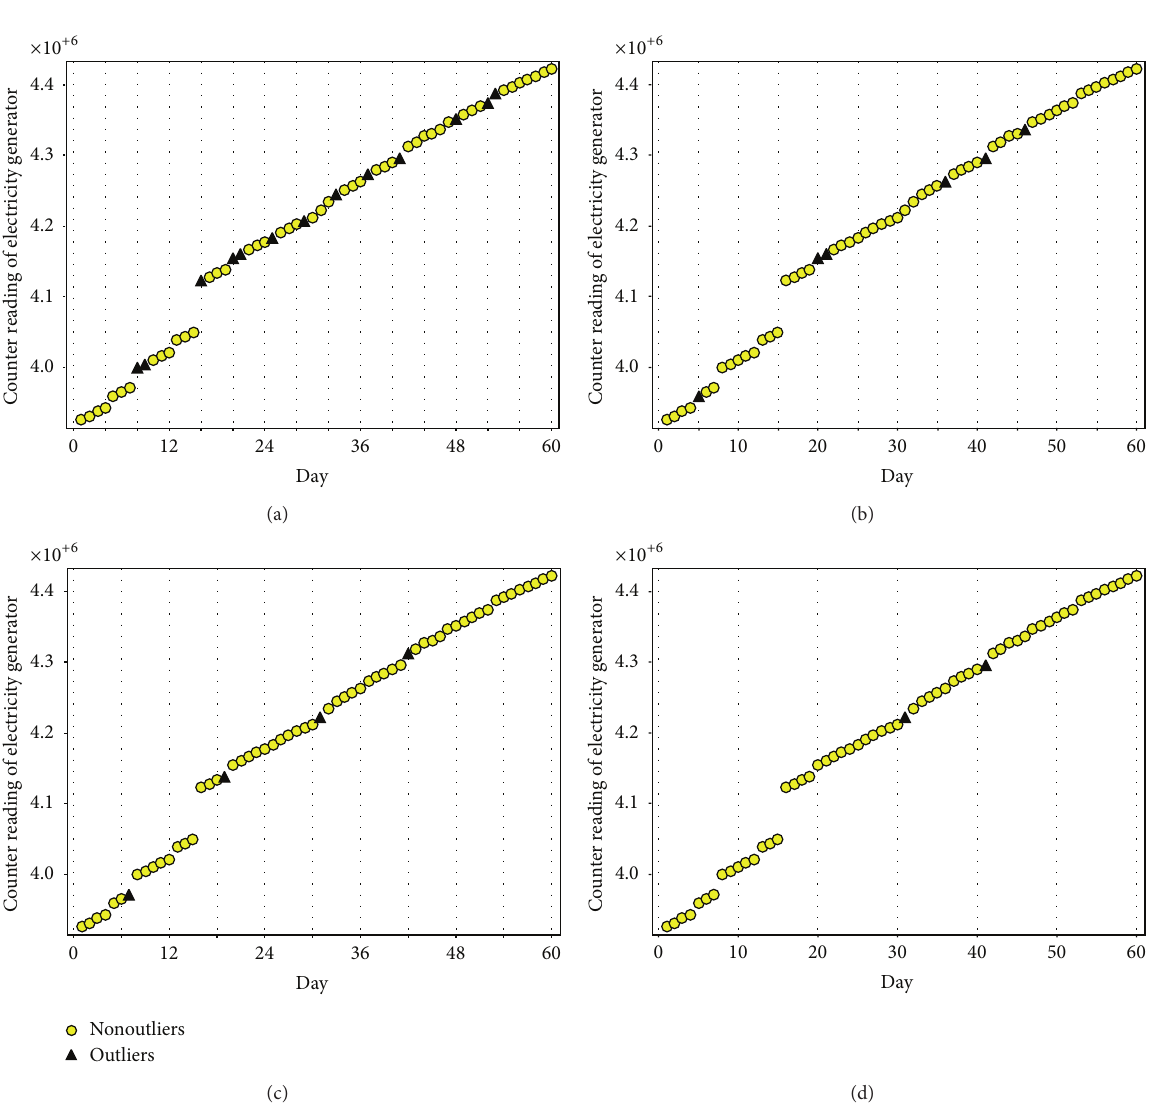
Figure 5: Outlier detection of the counter reading of electricity generator (operating hours) of the biogas plant with new transformation technique for significance level of 0.05 for different window sizes without overlap. Plots (a), (b), (c), and (d) correspond to window sizes 4, 5, 6, and 10,